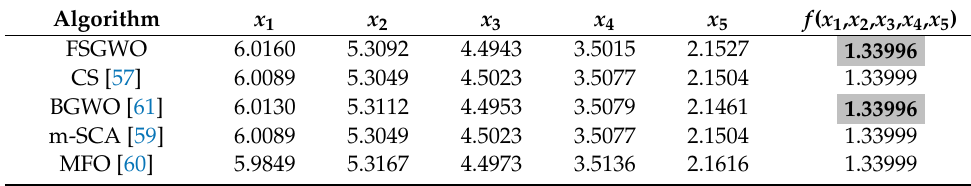
Table 17. Results of related algorithms for the cantilever beam design